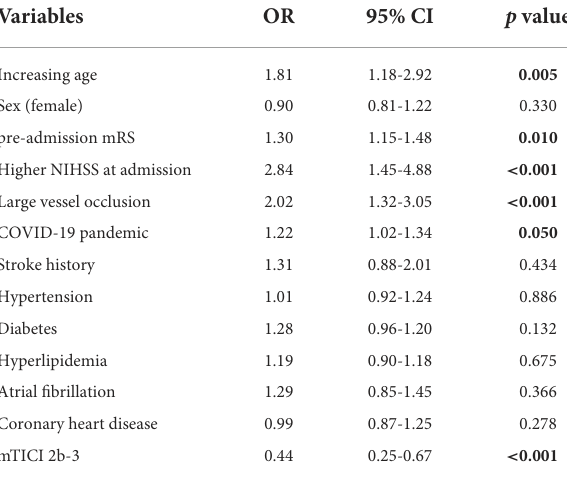
TABLE 6 Multivariate logistic regression analysis of influencing factors for short-term clinical poor outcomes (mRS ≥ 3).